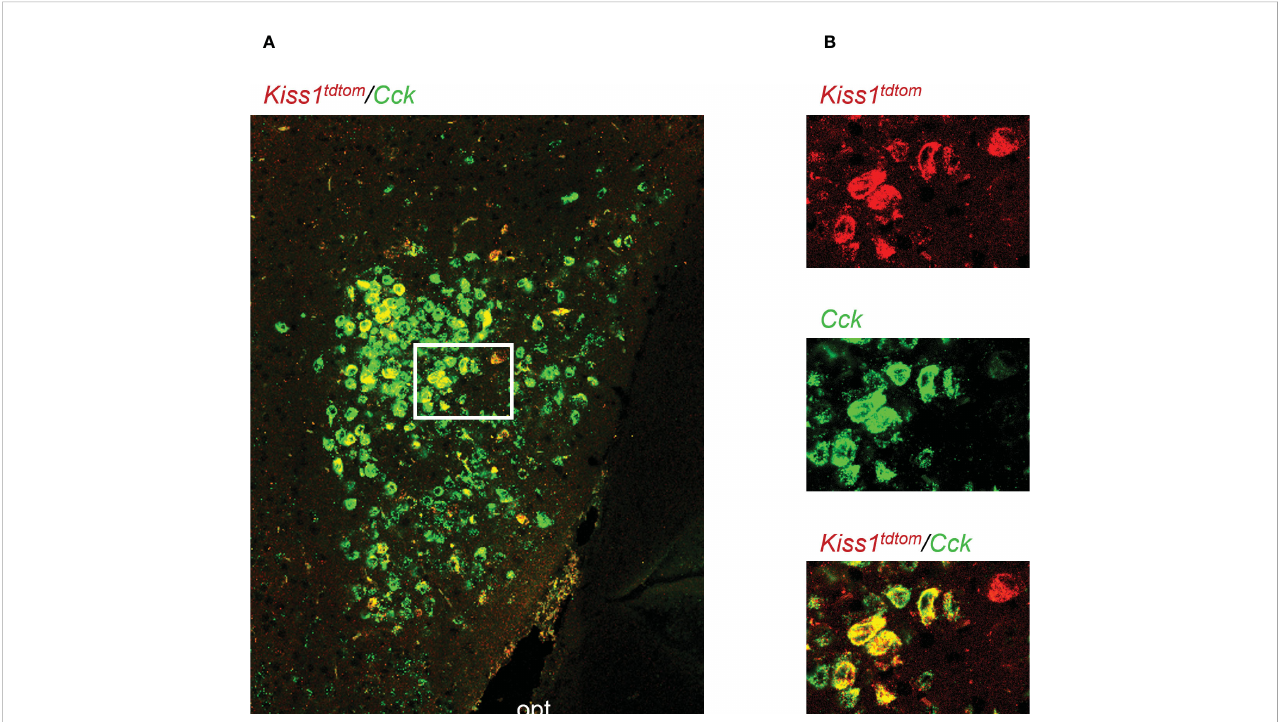
FIGURE 1 Double-label IHC/ISH of Kiss1 TdTomato cells and Cck in the female mouse medial amygdala. (A) A representative image of Kiss1 TdTomato cells (red) and Cck (green) of an E 2 -treated female mouse. (B) Higher magni fi cation images of the area in the white box showing a very high degree of Cck mRNA (green) expression in Kiss1 TdTomato cells (red). opt = optic